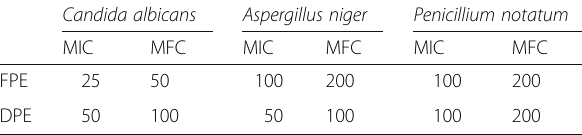
Table 4 Minimum inhibitory and fungicidal concentrations of Citrus sinensis peel extracts against some fungal strains expressed in μ